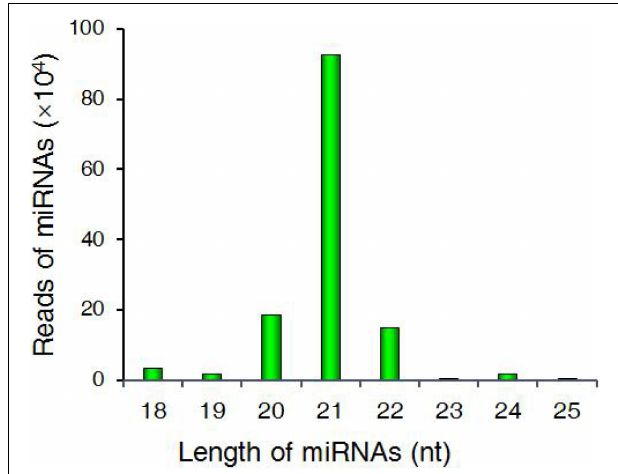
FIGURE 3 | Statistics corresponding to miRNAs differentially expressed between two samples. CK, T6, T12, T24, T48, and T72 correspond to 0, 6, 12, 24, 48, and 72 h after low-K + treatment,